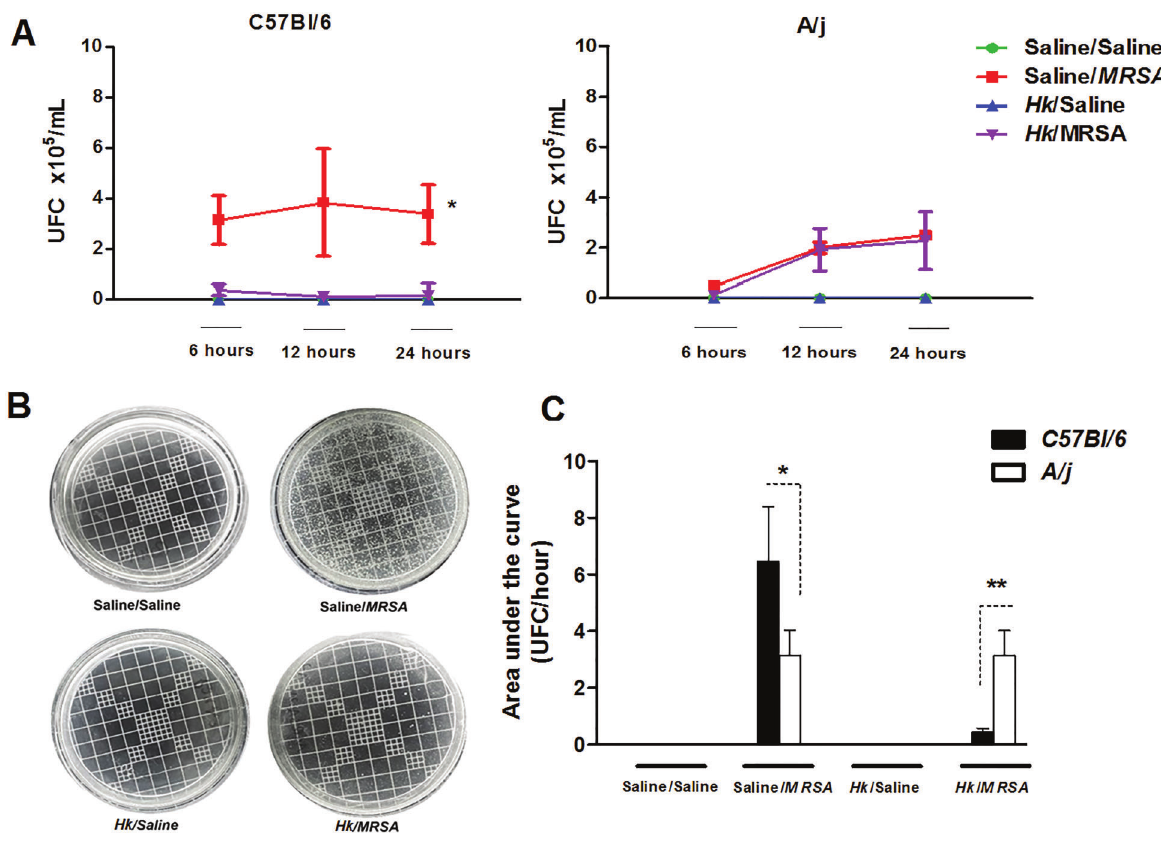
Figure 1. Bacterial load of Staphylococcus aureus in the air pouch in C57BL/6 and A/j mice previously immunized with 10 6 strains of MRSA inactivated by heat and challenged in the air pouch with 10 7 colony forming units (CFU) live MRSA. A , bacterial growth in both animal lineages. B , representation of growth in BHI medium for C57BL/6 mice (24 h). C , comparison of CFU in the two lineages. Data are reported as means ± SD (n=6). BHI: brain heart infusion ; Hk: Heat killed; MRSA: methicillin-resistant Staphylococcus aureus . *P o 0.05, **P o 0.01 ( A , Kruskal-Wallis test and Dunn ’ s post-test; C , Mann-Whitney test for comparisons between